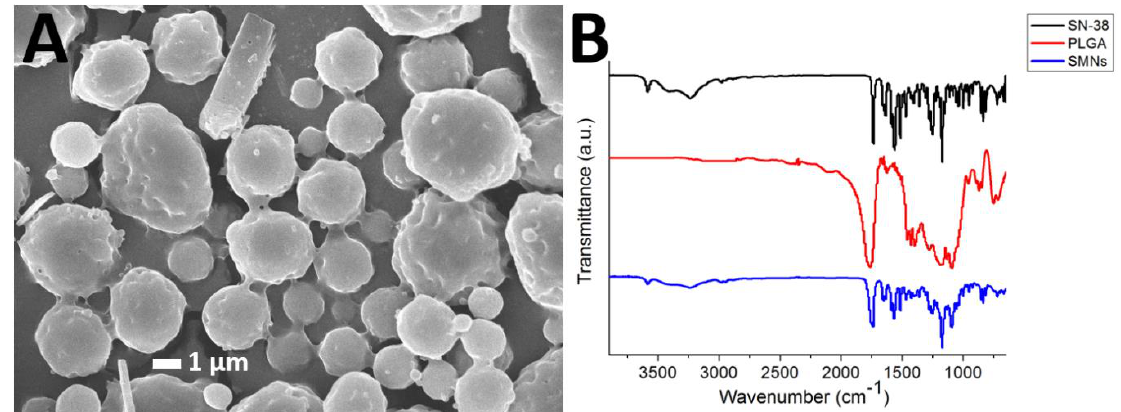
Figure 2. SN-38-embedded poly[( d , l )-lactide- co -glycolide] microparticles (SMPs) morphology. ( A ) Scanning electron microscopy (SEM) image of SMPs. The particles possess an average SMPs diameter of 1.58 ± 0.54 µm. ( B ) Fourier-transform spectra of the pharmaceuticals, pure poly[( d , l )-lactic- co -glycolide] microparticles, and SMPs.